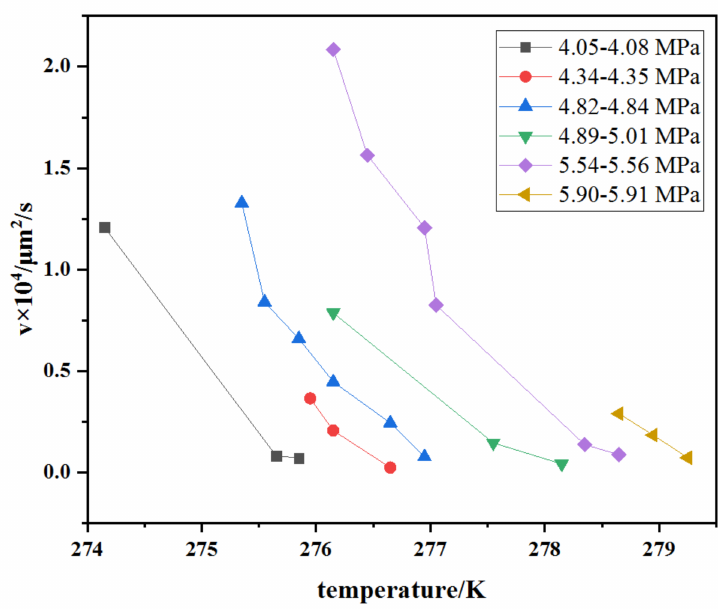
Figure 5. Lateral film growth rates at different temperatures and pressures.